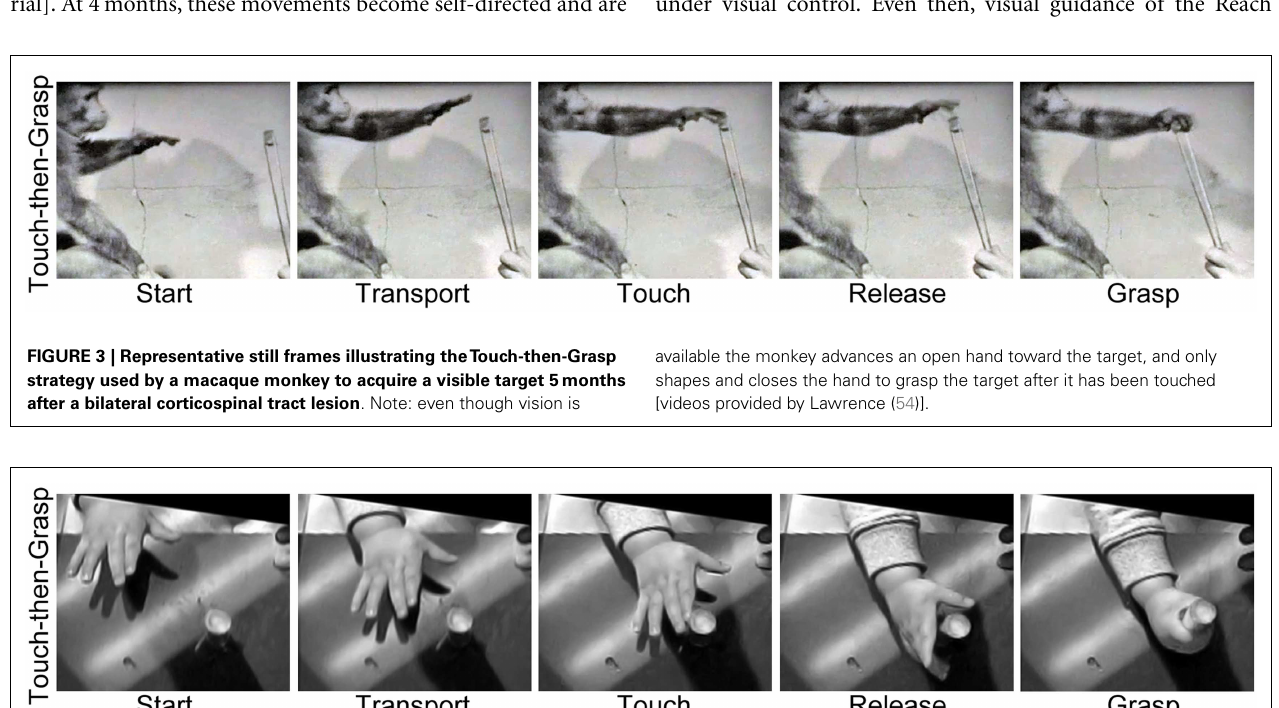
FIGURE 4 | Representative still frames illustrating theTouch-then-Grasp strategy used by a 7-month old human infant in order to acquire a visible target . Note: even though vision is available the infant advances an open hand toward the target, touches the target, and, only after contact, then re-orients, shapes, and closes, the hand to Grasp